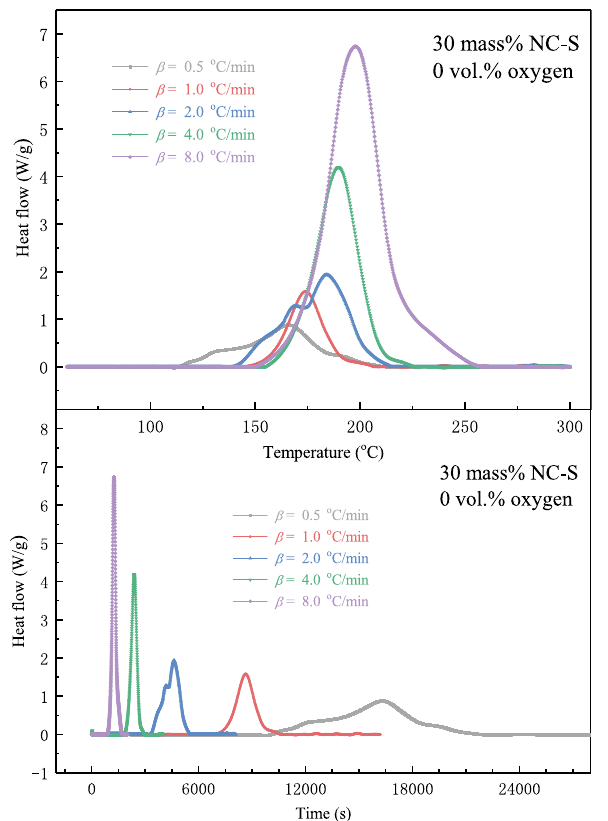
Figure 4. DSC exothermic curves of 30 mass% NC-S at various β in an oxygen-free environment.